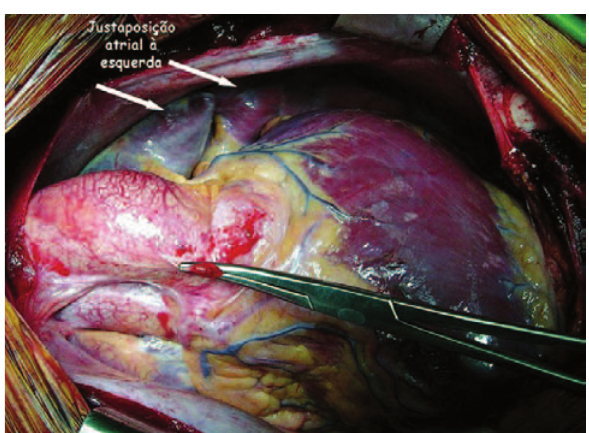
Fig. 2 - Justaposição dos apêndices atriais esquerdo e direito à esquerda